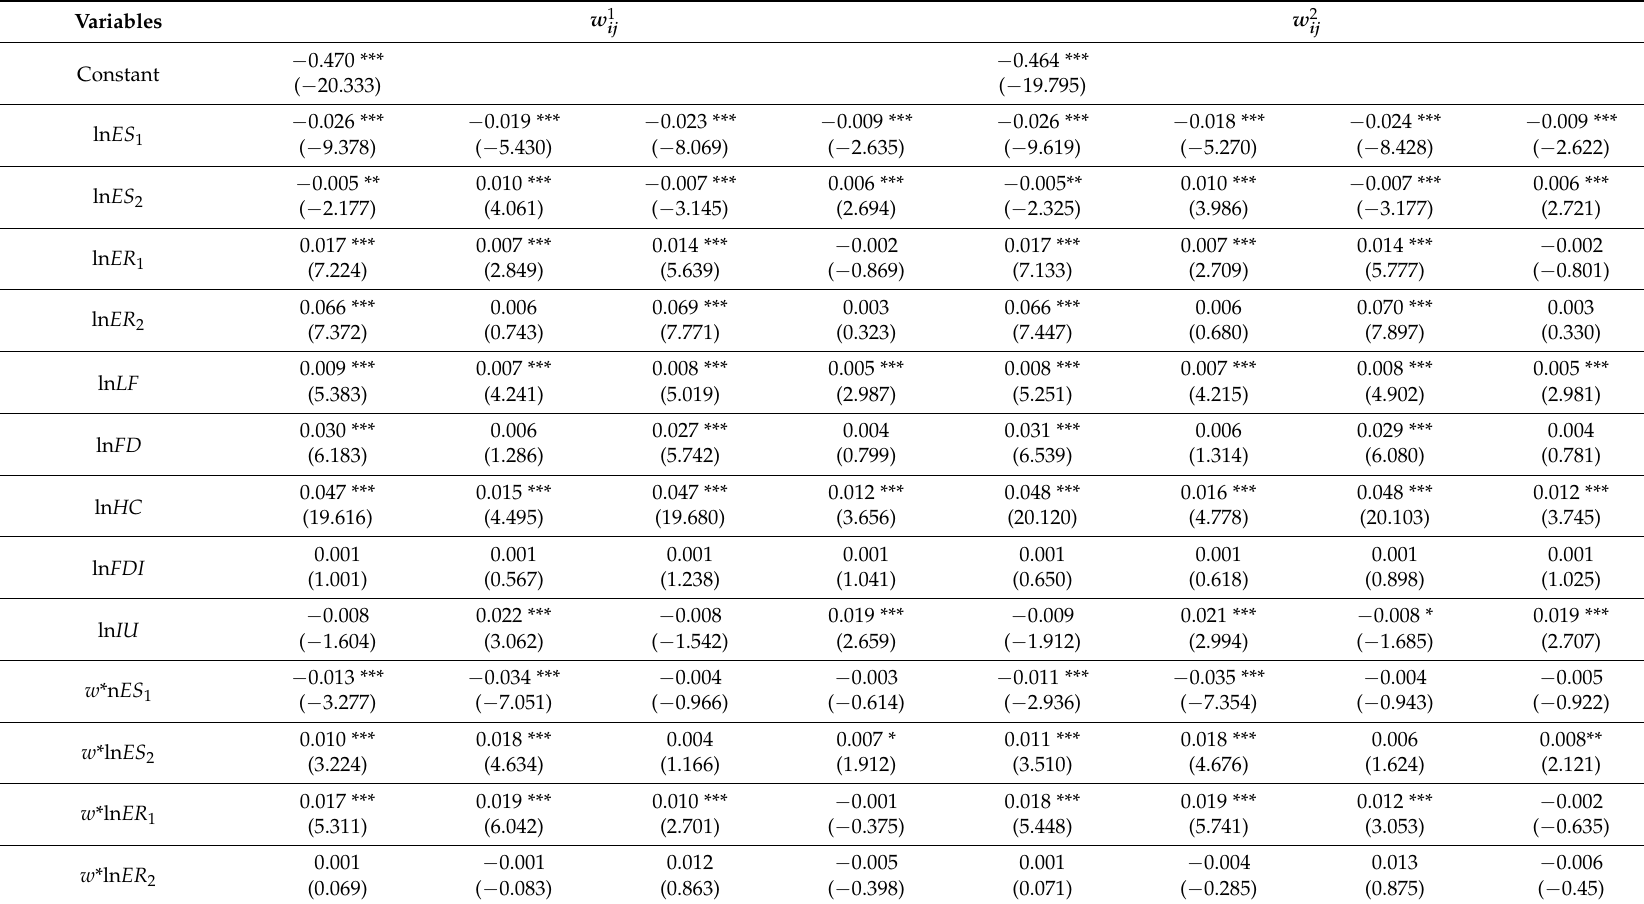
Table 4. The results for the whole